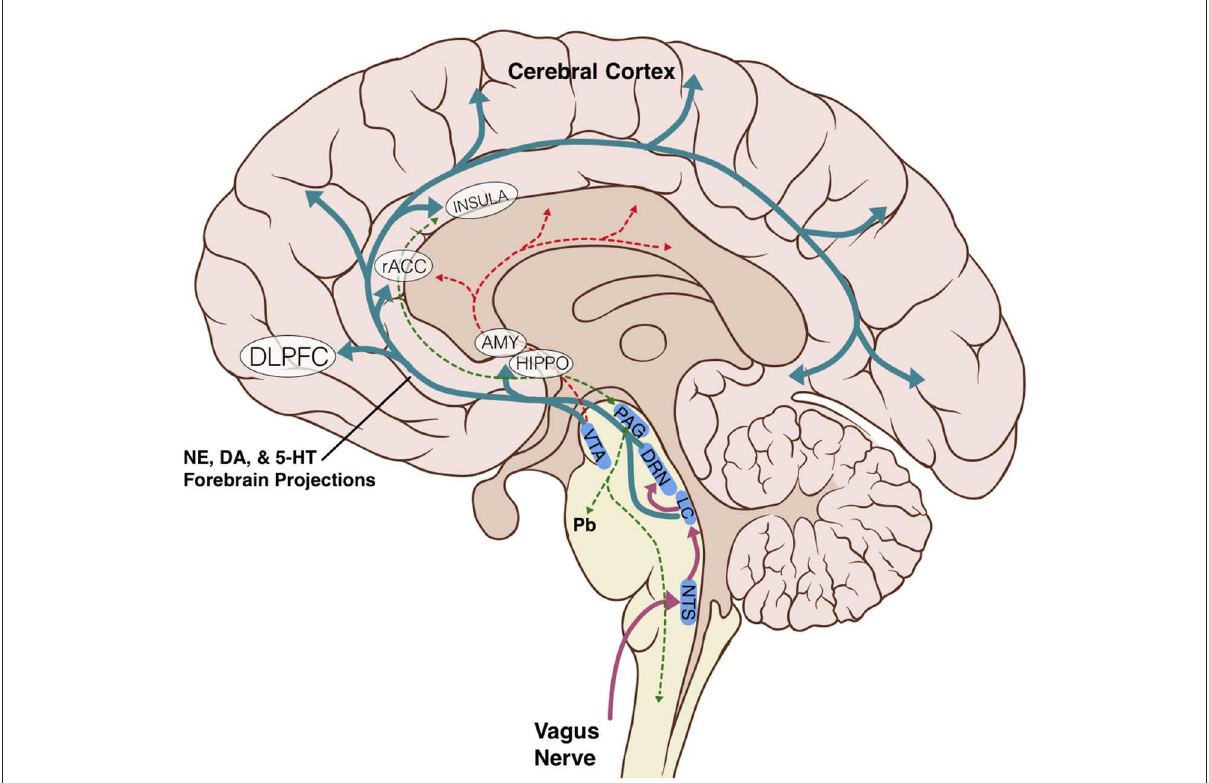
FIGURE1 Schematic representation of key brainstem-cortex circuits. DLPFC, dorsolateral-prefrontal cortex; rACC, rostral anterior cingulate cortex; INSULA, insular cortex; AMY, amygdala; HIPPO, hippocampus; VTA, ventral tegmental area; PAG, periaqueductal grey; DRN, dorsal raphe nucleus; LC, locus coeruleus; NTS, nucleus tractus solitarius; Pb, parabrachial nucleus; NE, norepinephrine; DA, dopamine; 5-HT, serotonin.